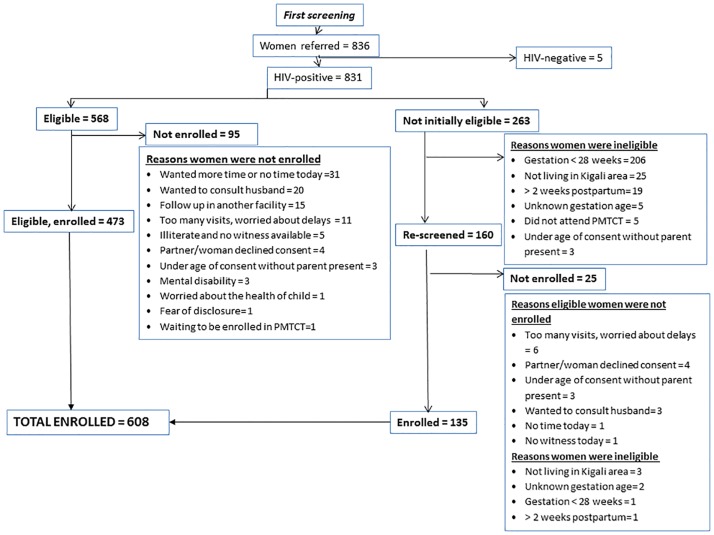
Kabeho Study Cohort Screening and Enrollment Diagram.